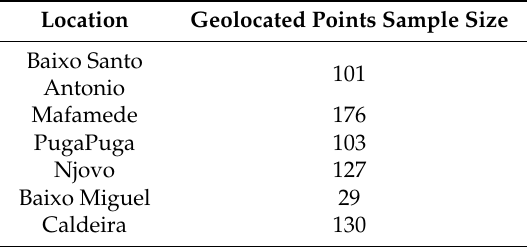
Table 2. Field data distribution per